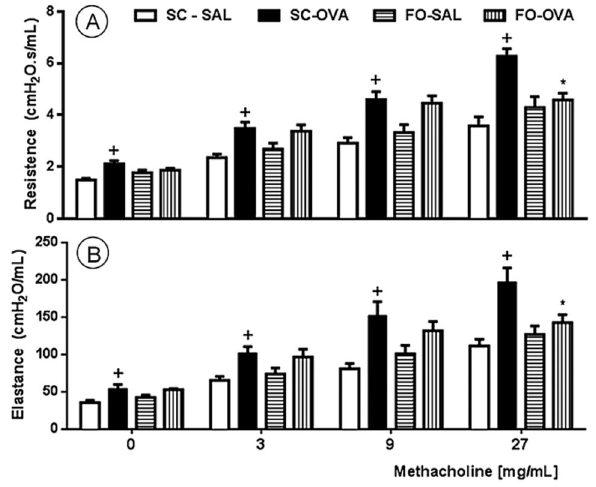
Figure 5. Effect of FO intake on allergen-induced changes in lung resistance (A) and elastance (B).